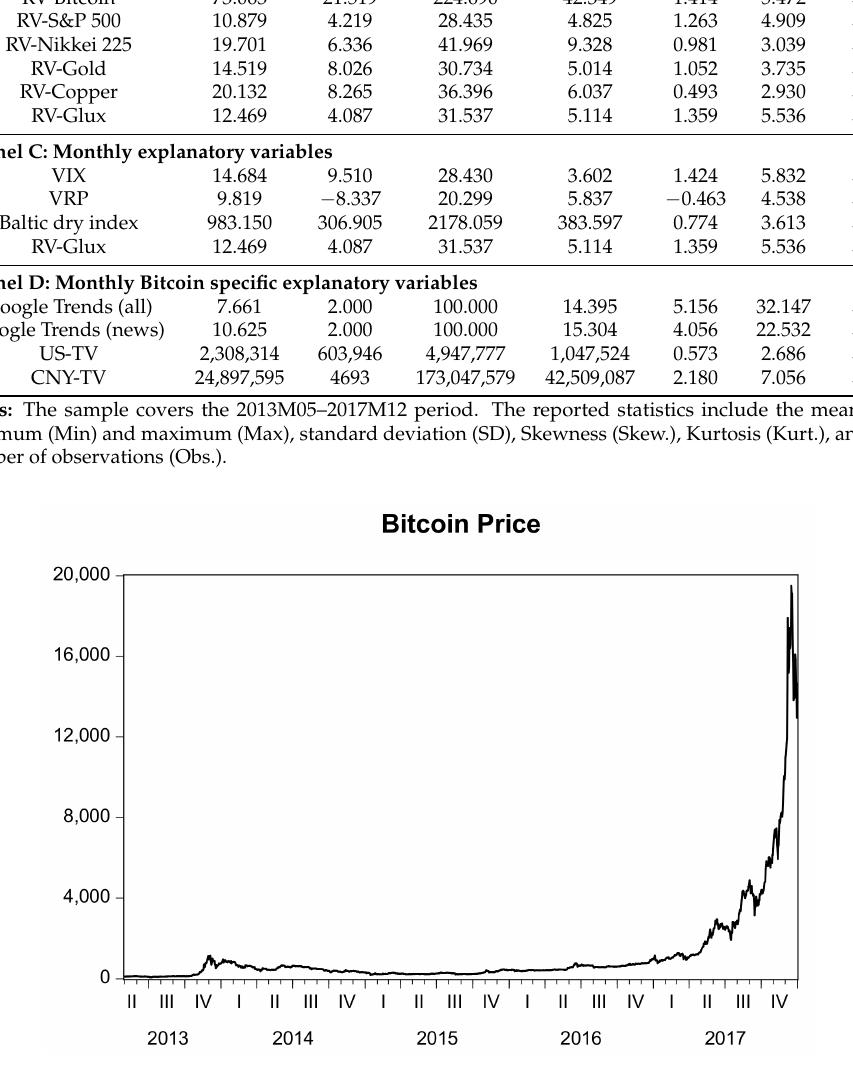
Figure 1. Bitcoin price development in the 2013:M5 to 2017:M12